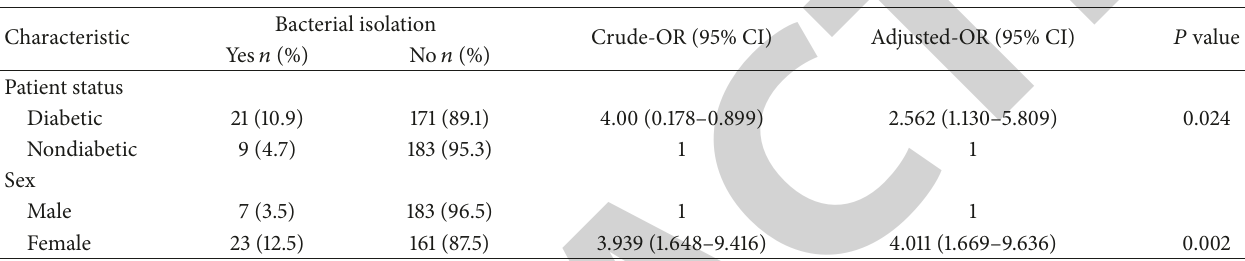
Table 5: Univariate and bivariate analysis of urinary tract infection among diabetic and nondiabetic patients attending Debre Tabor, Northwest Ethiopia,